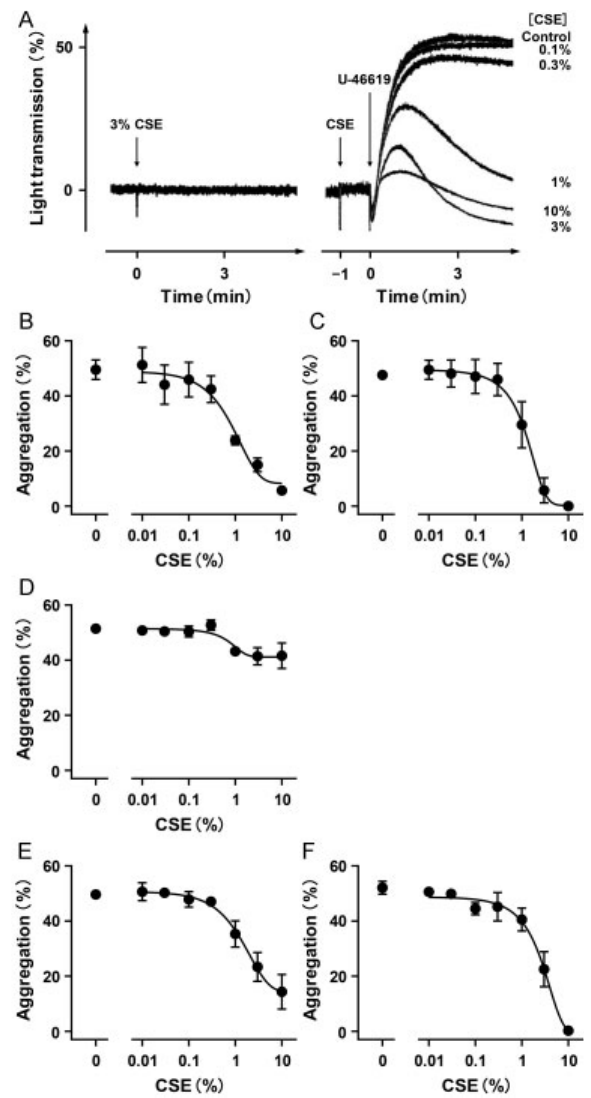
Fig. 1 Effects of cigarette smoke extract (CSE) on platelet aggregation. ( A ) CSE was added at the indicated concentration to PRP alone (left) or 1 minute before the addition of 3 μ M U-46619 (right). A decrease and an increase in light transmission indicate platelet shape change and platelet aggregation,respectively.Similarresultswereobtainedin fi veindependent PRP preparations, and representative results are shown. Control, no addition of CSE. U-46619 ( B ), collagen ( C ), and ADP ( D ) were added at concentrations to induce murine platelet aggregation of 40 to 55% (2.5 – 3.5 μ M), 40 to 55% (1.0 – 1.5 μ g/mL), and 45 to 55% (3.5 – 4.5 μ M), respectively.CSEwasaddedattheindicatedconcentrationtoPRP1minute before the addition of each stimulant. Each value is the mean (cid:1) SEM. ( B ) n ¼ 5; ( C ) n ¼ 6; ( D ) n ¼ 5. U-46619 ( E ) and collagen ( F ) were added at concentrations to induce human platelet aggregation of 45 to 50% (0.5 – 0.8 μ M) and 45 to 55% (0.5 – 1.0 μ g/mL), respectively. CSE was added at the indicated concentration to PRP 1 minutebefore the addition ofeach stimulant. Each value is the mean (cid:1) SEM, n ¼ 4.